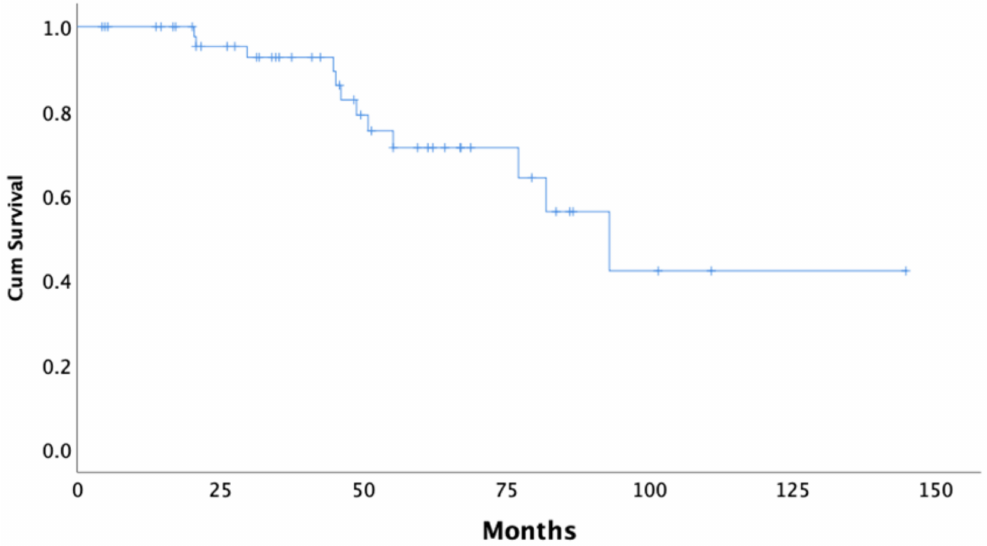
Figure 2. Kaplan–Meier curve of overall survival (OS) of all BRCA1/2 carriers. The univariate analysis showed that there was no significant association of the location or type of BRCA1/2 mutation with PFS or OS duration (Table 2). Despite numerical differences, pairwise comparisons between different functional domains of each gene also did not indicate any significant difference in either PFS or OS (Figure S1). The only characteristic that showed a correlation with survival outcome was surgical outcome, with patients having no residual disease following debulking surgery exhibiting a significantly higher PFS ( p < 0.001) and OS ( p = 0.028) compared to those with optimal or suboptimal surgical results (Table